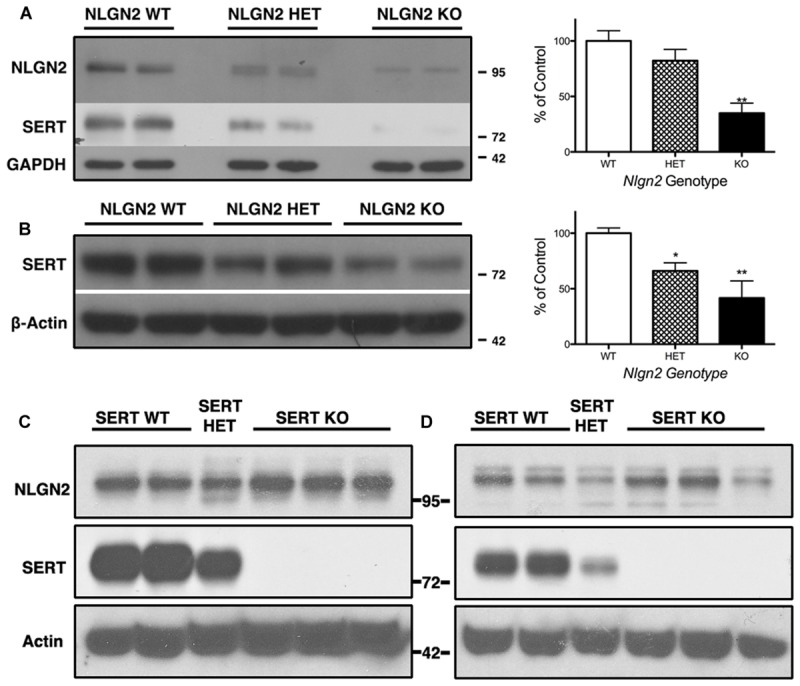
Nlgn2 null mice exhibit a midbrain-specific reduction in SERT expression. Western blots of SERT protein in (A) midbrain and (B) hippocampus. NLGN2 protein levels are not different between SERT null mice and their WT littermates in midbrain (C) or hippocampus (D). For (A)
∗∗∗P = 0.001, one-way ANOVA; ∗∗P < 0.01 for WT vs. null and ∗P < 0.05 for HET vs. null, Bonferroni’s Multiple Comparison Test, N = 5 for each genotype. For (B)
P = 0.003, one-way ANOVA; ∗P < 0.05 for WT vs. HET and WT vs. null, Bonferroni’s Multiple Comparison Test. N = 5 for each genotype.